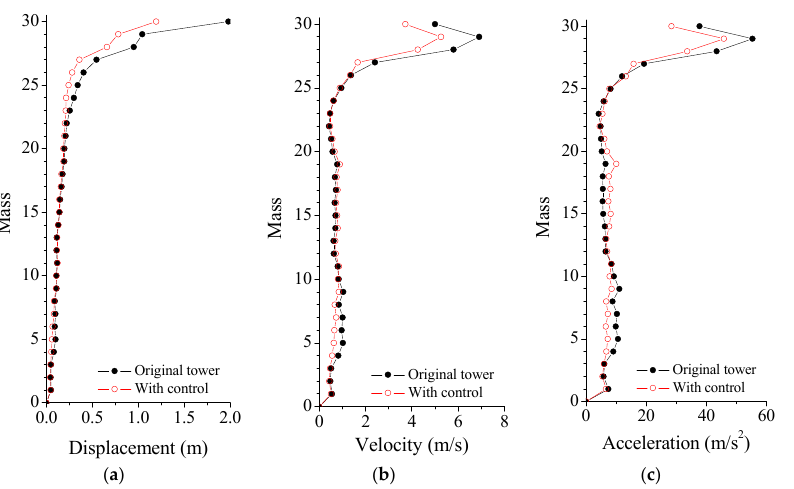
Three damper installation schemes are considered to compare the effects of damper position on control efficacy, as listed in Table 3. Scheme 1 is mentioned above, in which sixty dampers are around the two turrets. For scheme 2, all the SMA dampers are in- stalled around the low turret (Mass No. 4). For scheme 3, all the SMA are installed Figure 5. Maximum responses of the tower without/with control. ( a ) Displacement; ( b ) Velocity; around the upper turret. ( c ) Acceleration.